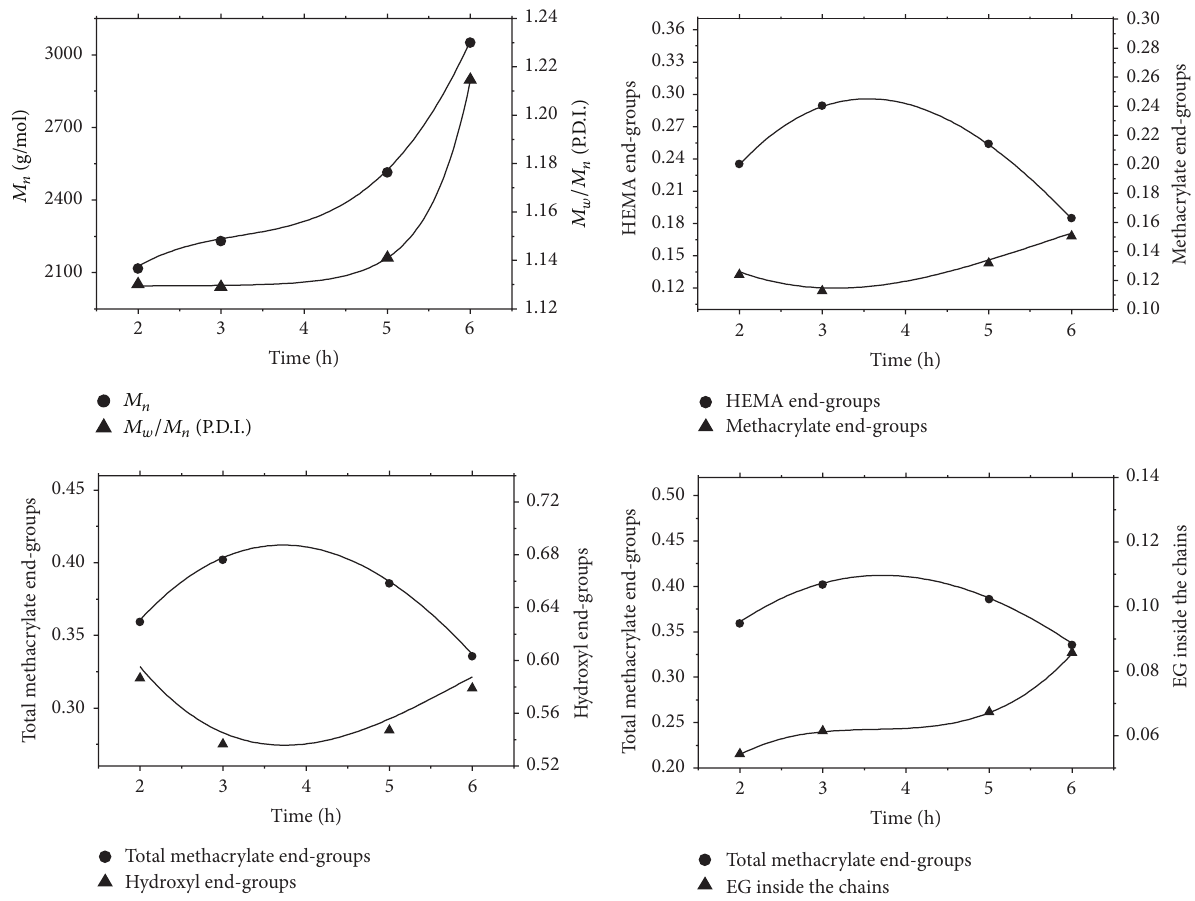
Figure 5: The effect of reaction time (2h, 3h, 5 h, and 6 h) on 𝑀 𝑛 , polydispersity, HEMA, methacrylate, total methacrylate, hydroxyl end- groups, and EG inside the chains (Synthesis at 70 ∘ C, 9 mmole/45 mmole (0.2) HEMA/CL ratio, and 100 mg